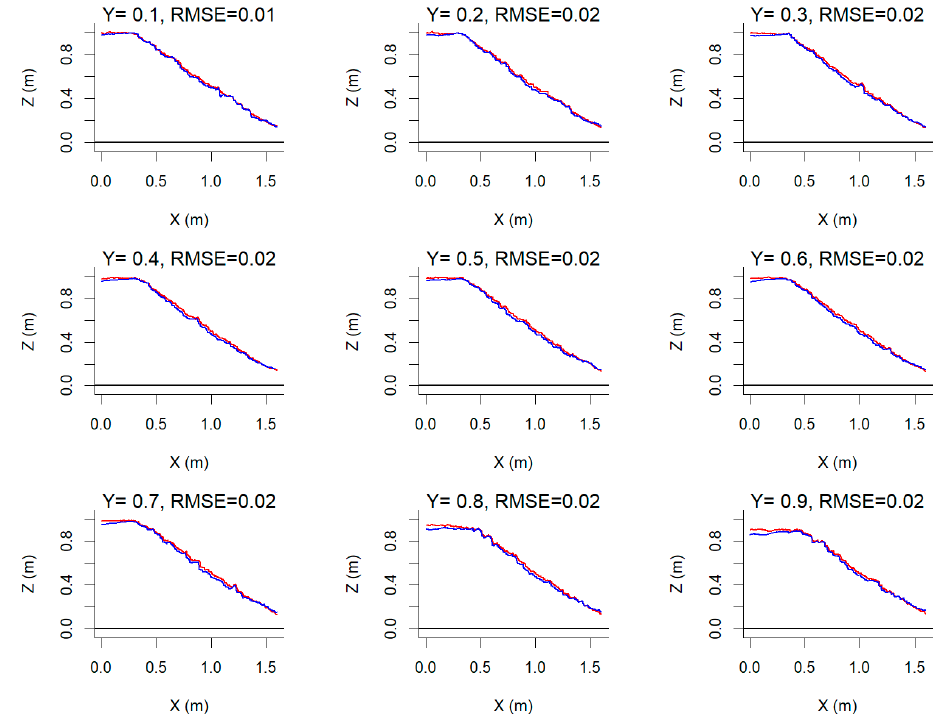
Figure 17. Longitudinal profiles of test U1; high-resolution DEM (red) and low-resolution DEM (blue); nine different profiles, with 0.1 being close to the back wall and 0.9 being near the glass wall (with pilot channel visible); calculated RMSE is shown for each profile.